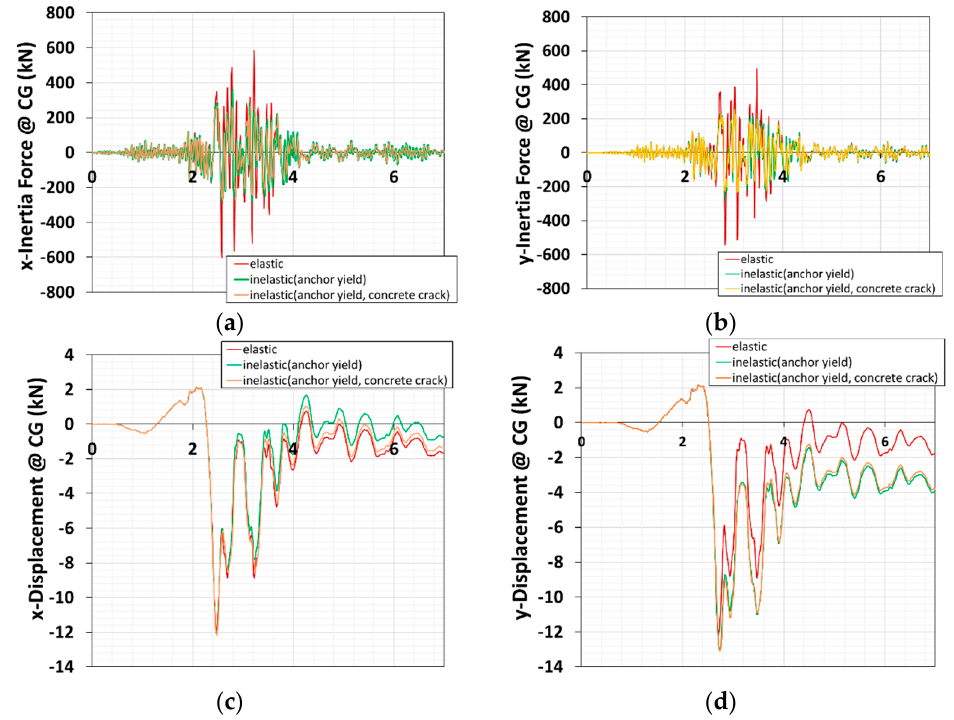
Figure 20. Lateral inertial forces: ( a ) x dir., ( b ) y dir. and displacements: ( c ) x dir., ( d ) y dir. at the center of gravity.